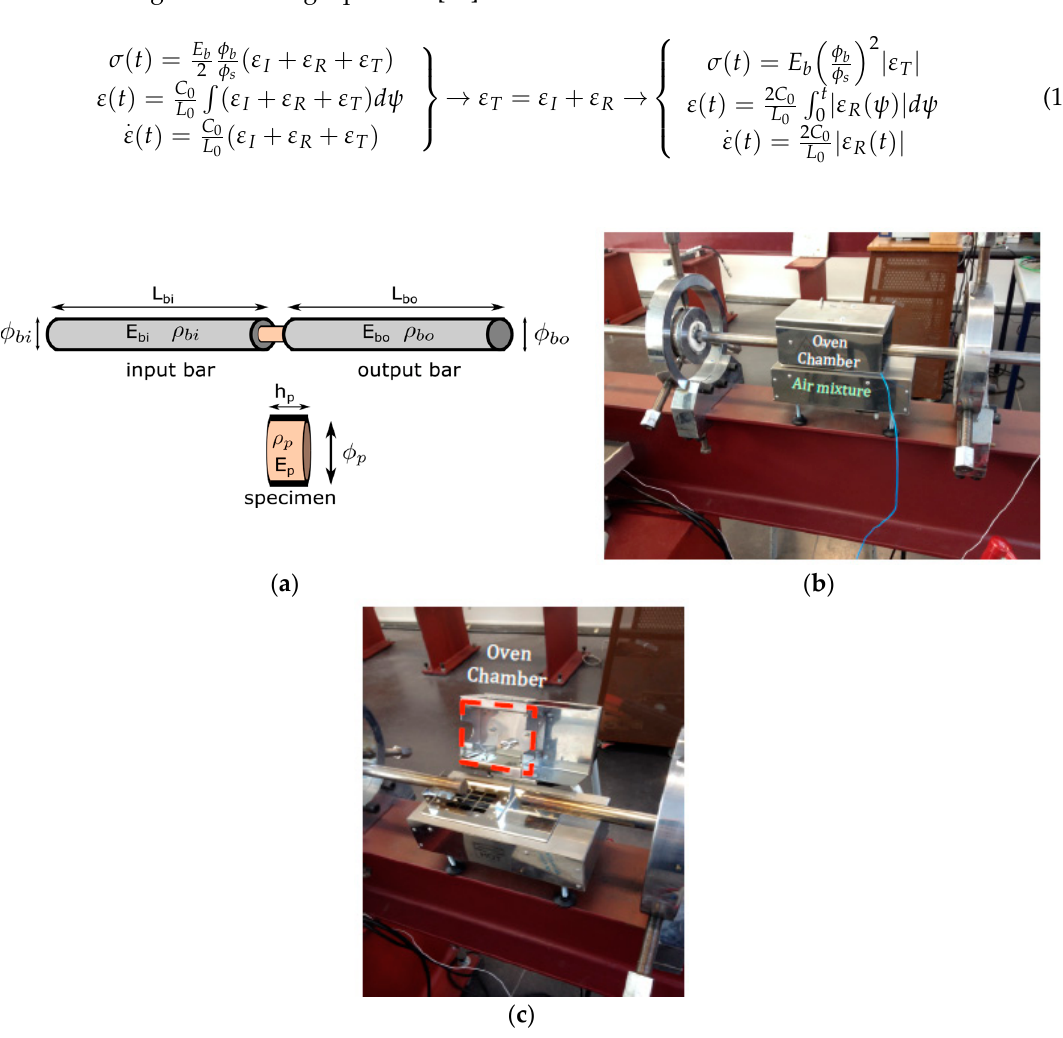
Figure 2. ( a ) Scheme of the experimental device, including relevant properties of the input and output bars and specimens (E, Young modulus; ρ , density), and dimensions (length; diameter); ( b ) Split Hopkinson pressure bars used during dynamic tests with the furnace coupled for temperature testing; ( c ) Details of the furnace. Table 2. Parameters of the split Hopkinson pressure bar.